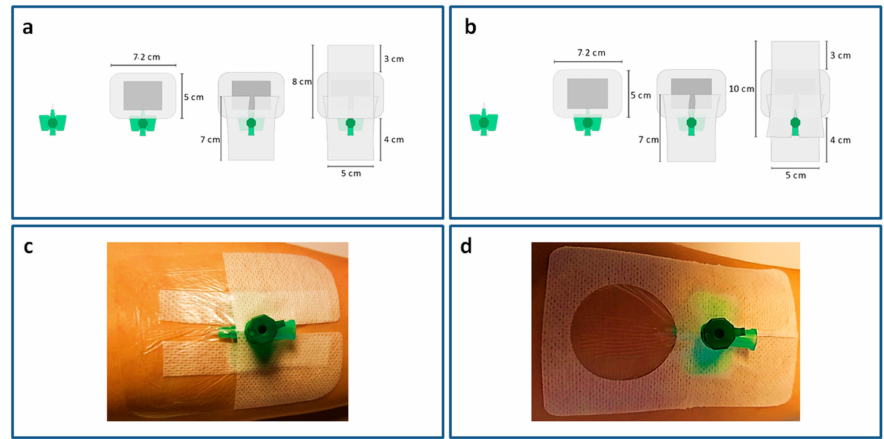
Figure 1. Four securements: ( a ) sterile wound dressing covered by two elastic polyester fleece dressings, one incised; ( b ) sterile wound dressing covered by two elastic polyester fleece dressings, both incised; ( c ) non-bordered transparent polyurethane film dressing; ( d ) bordered polyurethane film dressing (nonwoven polyester with polyurethane film laminate).